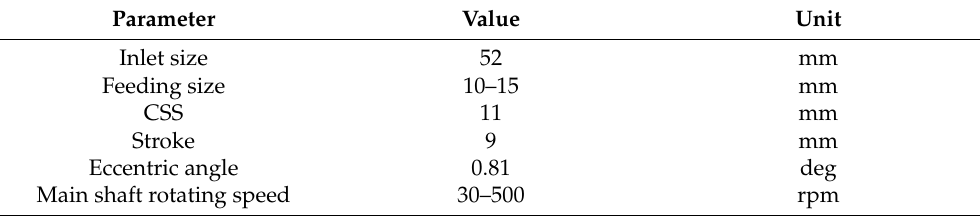
Table 1. The structural and operating parameters of reduced-scale experimental cone crusher. Parameter Value Unit Inlet size mm Feeding size Stroke mm Eccentric angle 0.81 deg Main shaft rotating speed 30–500 rpm